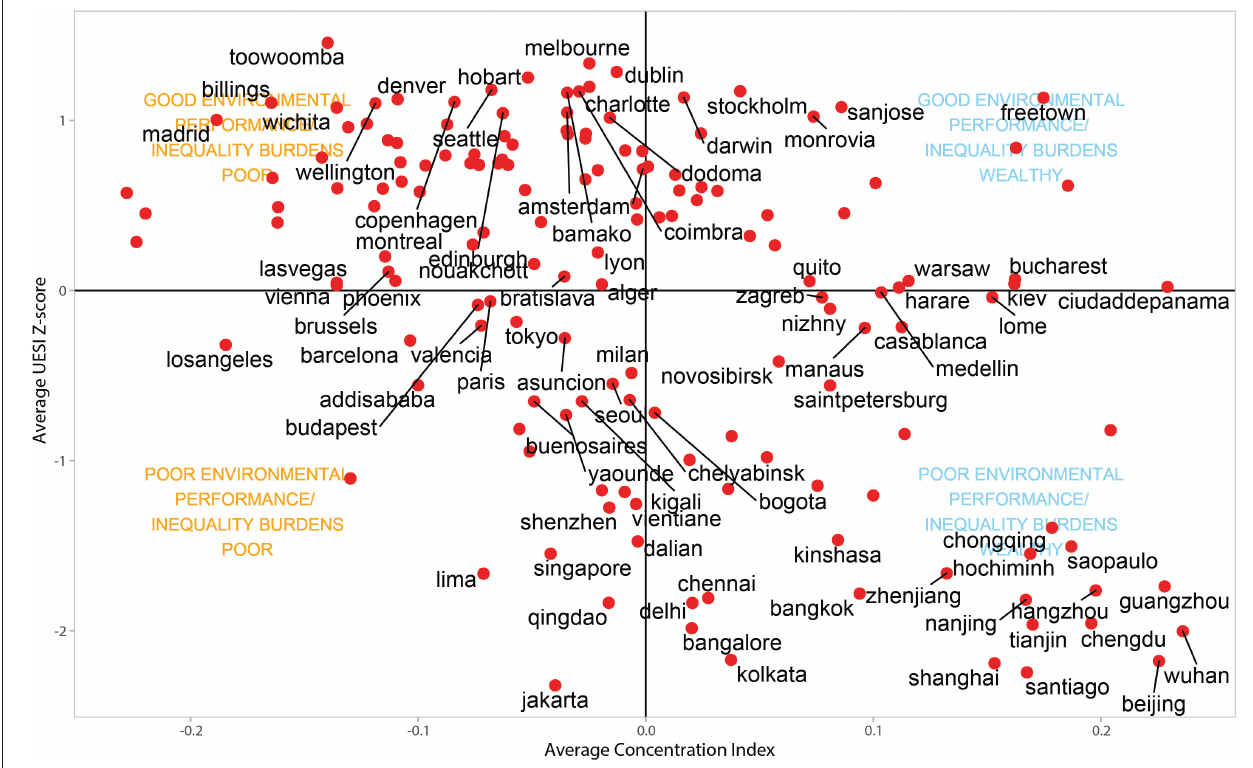
FIGURE 3 | A four-quadrant plot examining the relationship between environmental performance (measured by average z-score of a city’s performance on the five spatially-explicit indicators) and equity (measured by average environmental concentration index values on the five spatially-explicit indicators).